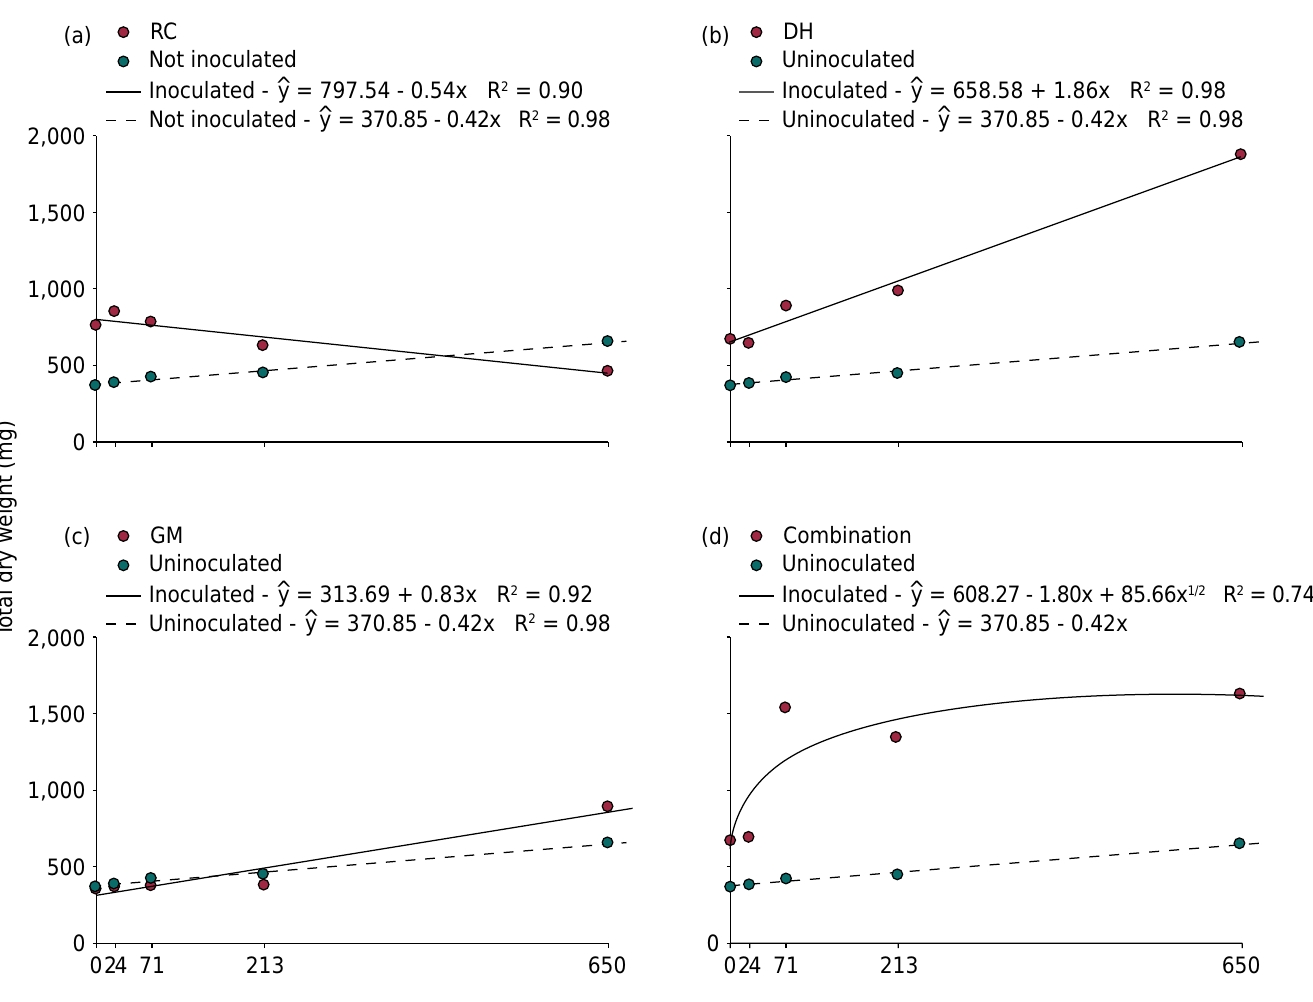
Figure 2. Response curves for phosphorus rates of Apuleia leiocarpa seedlings inoculated with (a) Dentiscutata heterogama (DH) and without inoculation, (b) Rhizophagus clarus (RC), (c) Gigaspora margarita (GM), and (d) with a mix of Dentiscutata heterogama , Gigaspora margarita , and Rhizophagus clarus